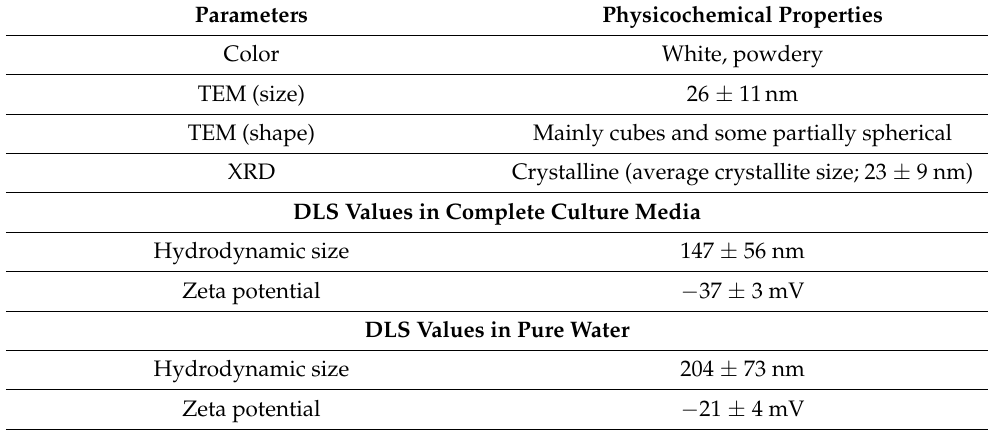
Table 1. Summary of physicochemical properties of CeO 2 -Zn